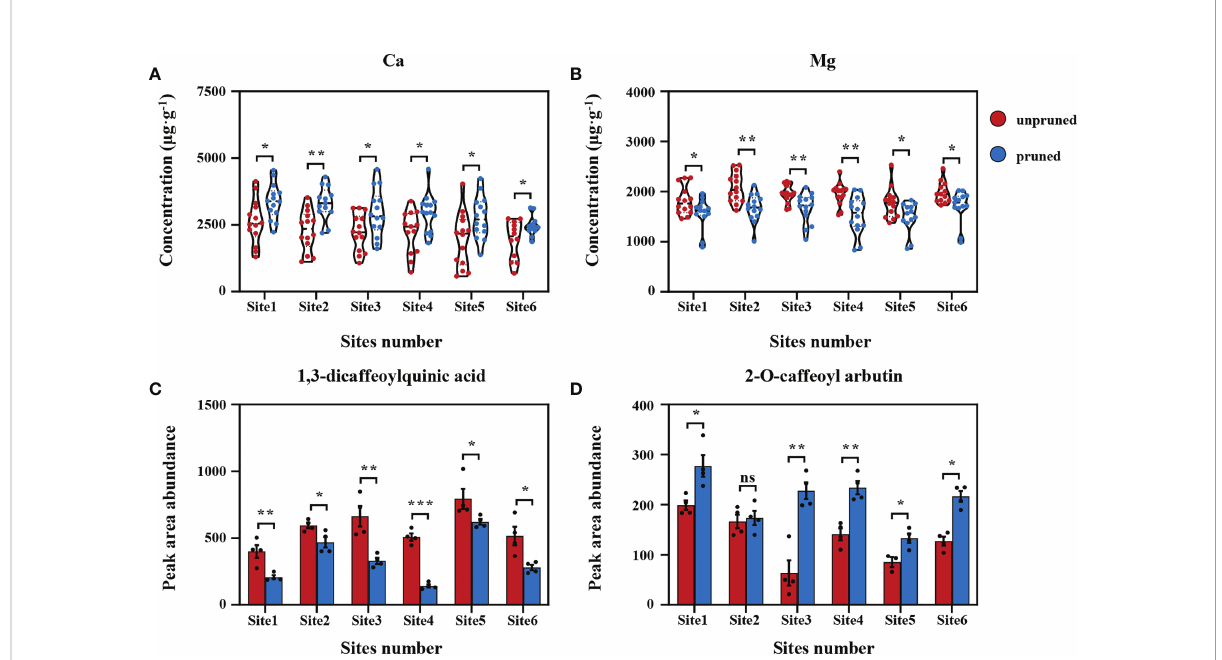
FIGURE 4 Difference analysis of fresh tea leaf samples from representative sites. Comparisons of calcium (A) and magnesium (B) concentrations in fresh tea leaves from representative sites. Comparisons of 1,3-dicaffeoylquinic acid (C) and 2-O-caffeoyl arbutin (D) relative contents in fresh tea leaves from representative sites. Values are shown as means ± standard errors. Statistically signi fi cant differences between groups were tested by the Student ’ s t test. ***: P ≤ 0.001, **: 0.001 < P ≤ 0.01, *: 0.01 < P ≤ 0.05, ns: no signi fi cant